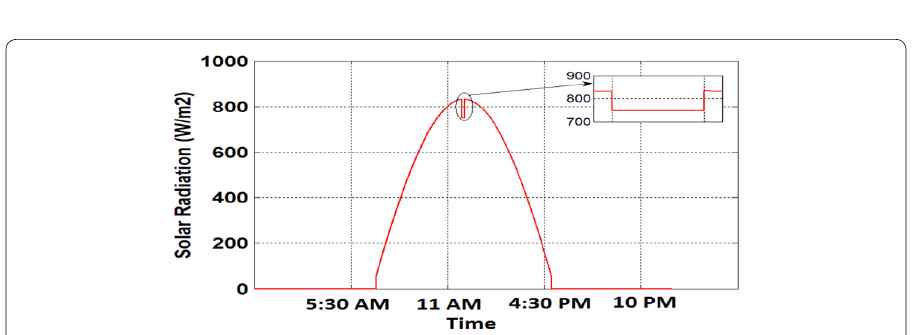
Fig. 14 Solar radiation with 10%